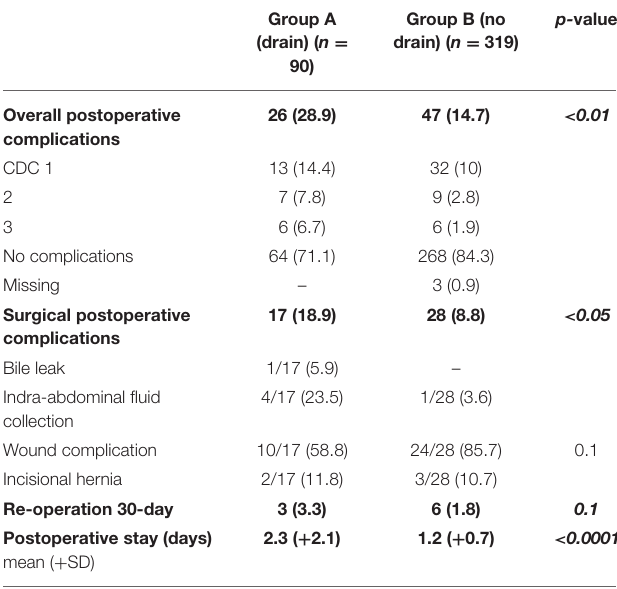
TABLE 2 | Postoperative